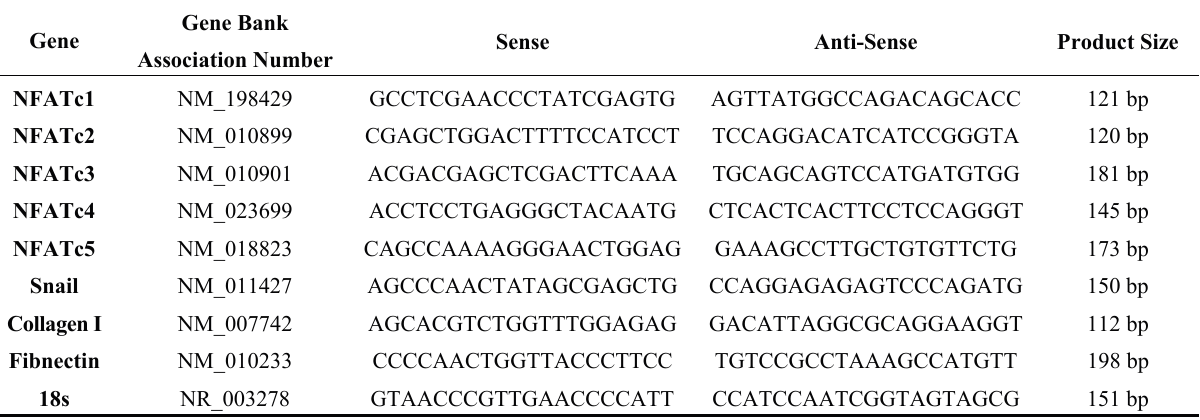
Table 2. The sequences of the real time PCR